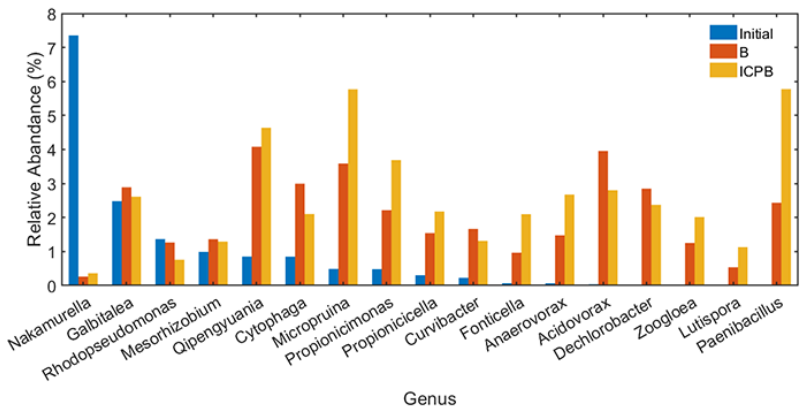
Figure 11. Other genera with a relative abundance of more than 1% in the samples of initial, B, and ICPB. Initial—the sample before the reaction; B and ICPB—the samples of the biodegradation and coupling, respectively.